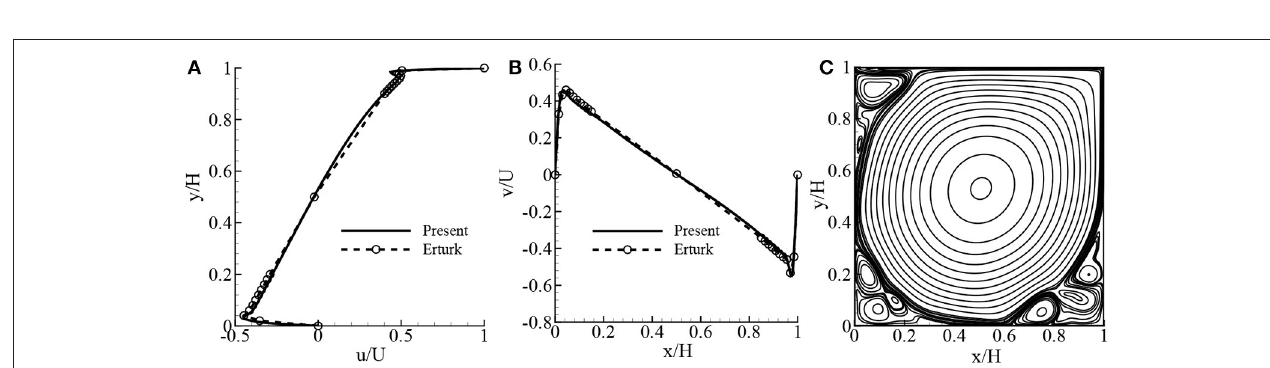
FIGURE 6 | Comparison of the lid-driven cavity flow with the results of Erturk et al. (2005) (finite difference solutions): (A) u / U - velocity at mid x / H , (B) v / U - velocity at mid y / H , and (C) streamlines while Re 20,000 after 5,000,000 iterations. =